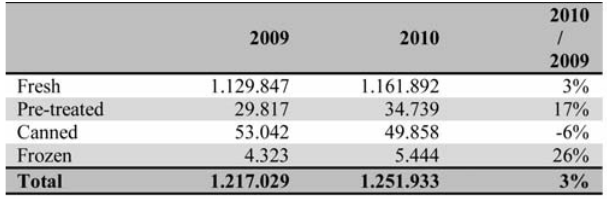
Table 10. Supermarket sales of fruit ( € x